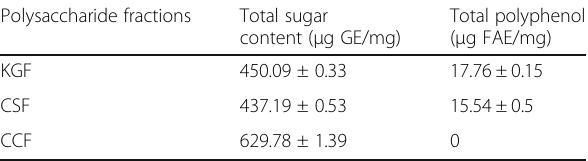
Table 2 Total sugar and polyphenols content of polysaccharides fractions of Khaya grandifoliola stem bark (KGF), Cryptolepis sanguinolenta (CSF) and Cymbopogon citratus (CCF) leaves by Phenol-sulfuric and Folin-Ciocalteu methods (mean ± SEM; n = 3) Polysaccharide fractions